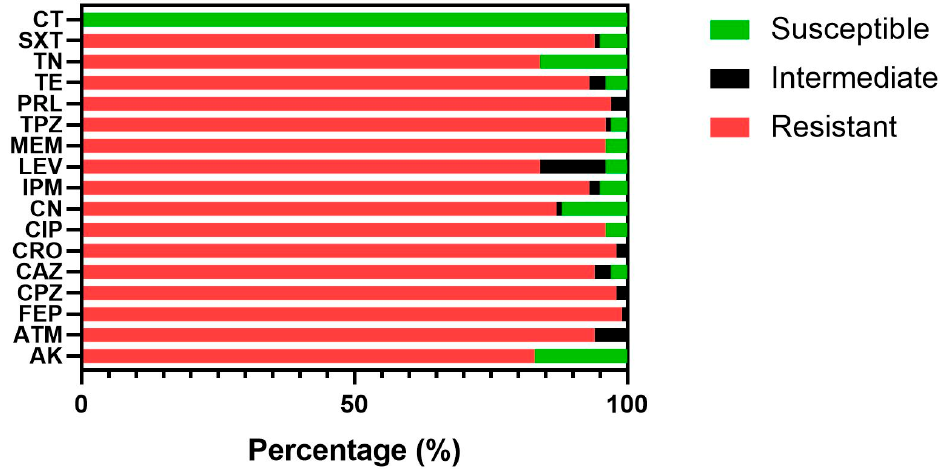
Figure 1. Antibiotic susceptibility testing of 120 A. baumannii isolates against a panel of 17 antibiotics